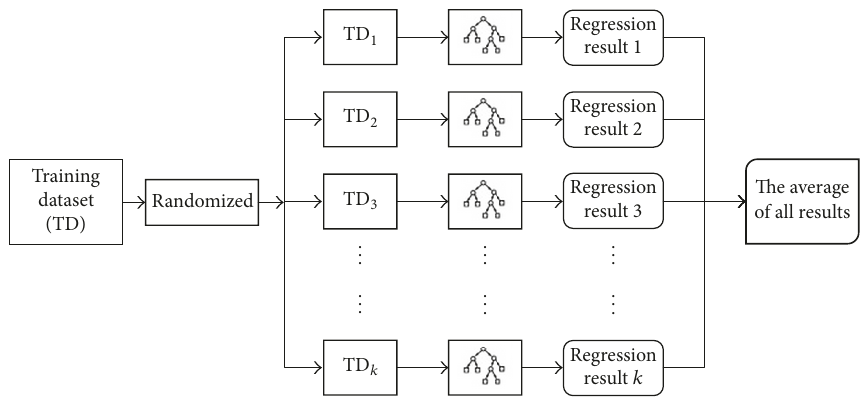
Figure 3: Structure of a random forest